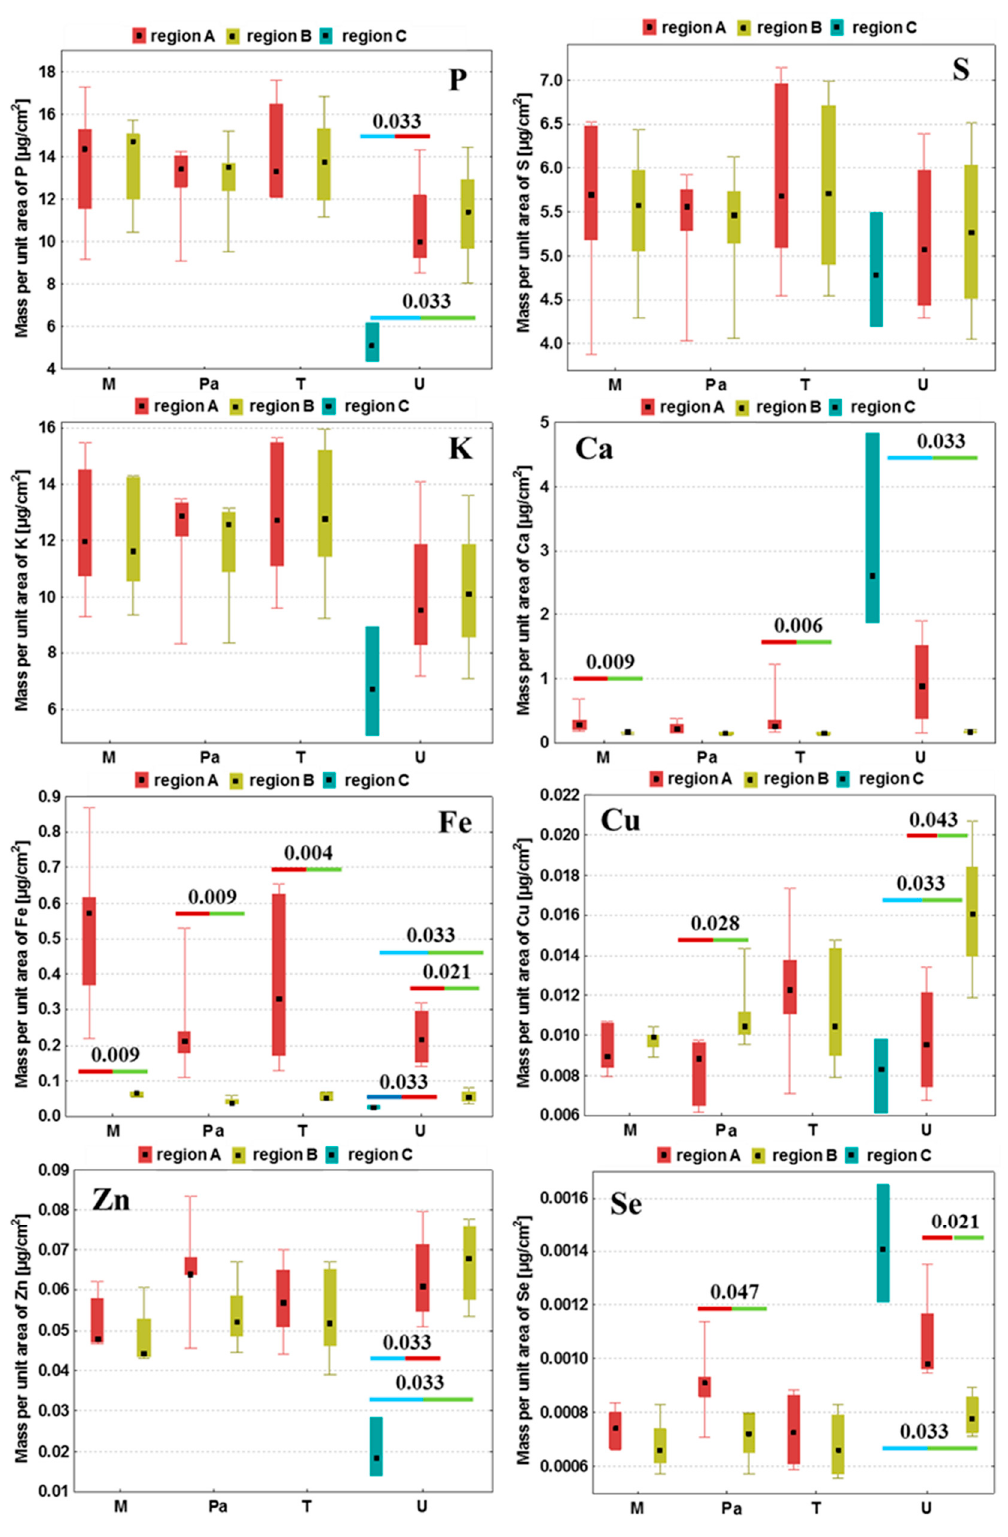
Figure 5. Medians, minimal and maximal values as well as interquartile spans of areal densities of P, S, K, Ca, Fe, Cu, Zn and Se in the examined tissue regions obtained for groups M, Pa, T and U. Region A—tumor (groups Pa and U) or place where DMEM/T98g cells were administered (groups M and T, respectively); region B—surroundings of the tumor or place where DMEM/T98g cells were administered; C—tumor debris defined in the case of the U group. Statistically significant differences between the compared areas within the same experimental group were marked with p -values of the U test.